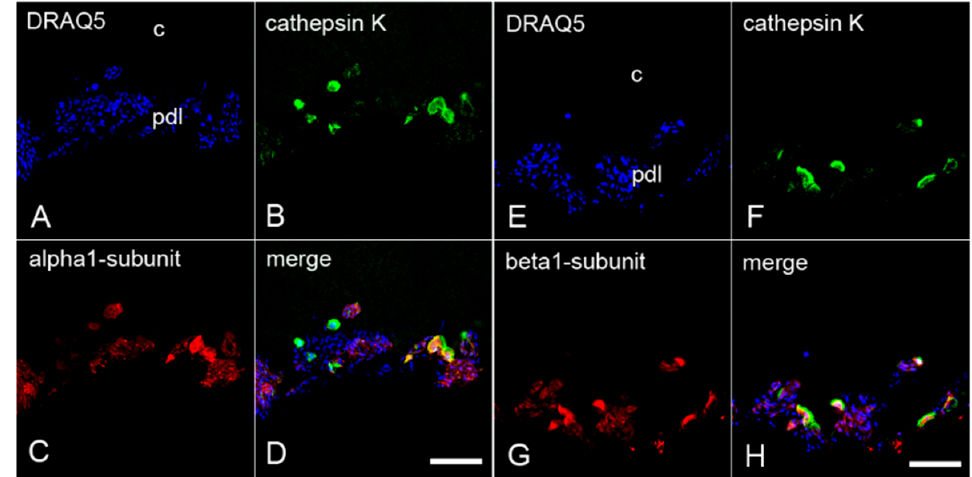
Figure 5. Colocalization of the α 1 - and β 1 -subunits of sGC with cathepsin K in cementoclasts of inflamed human periodontium: sections of a representative molar with adherent clinically inflamed periodontium were stained with DRAQ5 ( A , E ) and incubated with antibodies for cathepsin K ( B , F ), α 1 -subunit ( C ), and β 1 -subunit ( G ) of sGC. Colocalization of cathepsin K with the α 1 -subunit ( D ) and β 1 -subunit ( H ) in cementoclasts is depicted in the merged images. c = cementum, and pdl = periodontal ligament. Scale bar = 100 µm ( D , H ).